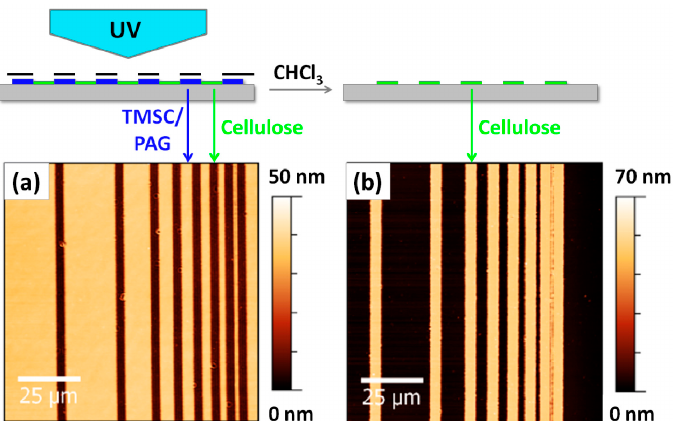
Figure 2. AFM images of TMSC ultrathin films using a photolithographic mask after irradiation ( a ) and rinsing ( b ). The smallest structure has a size of ca. 1 μ m and wavelengths below 365 nm have been excluded by an emissive filter to prevent degradation of cellulose during the illumination